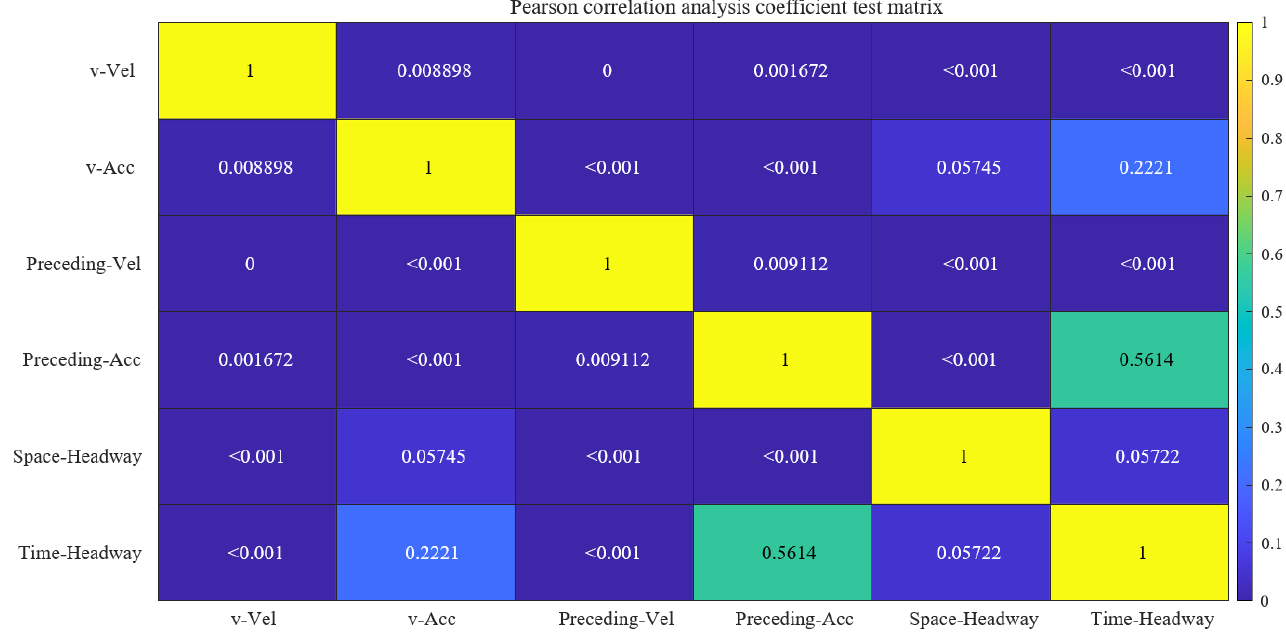
Figure 3. Pearson coefficient analysis results of the six empirical variables.